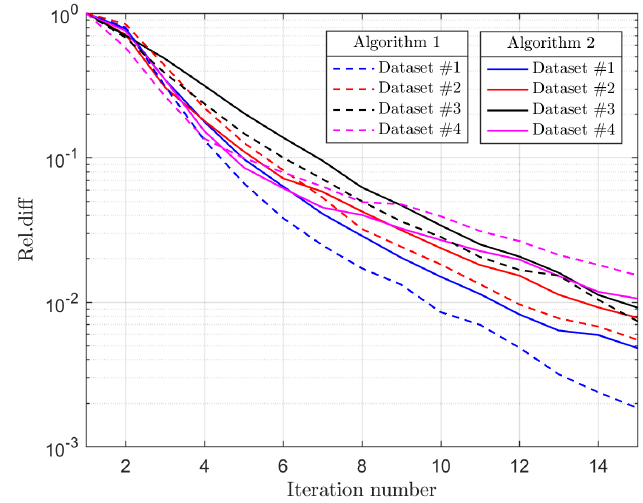
Figure 6. Convergence performance of AWSG.